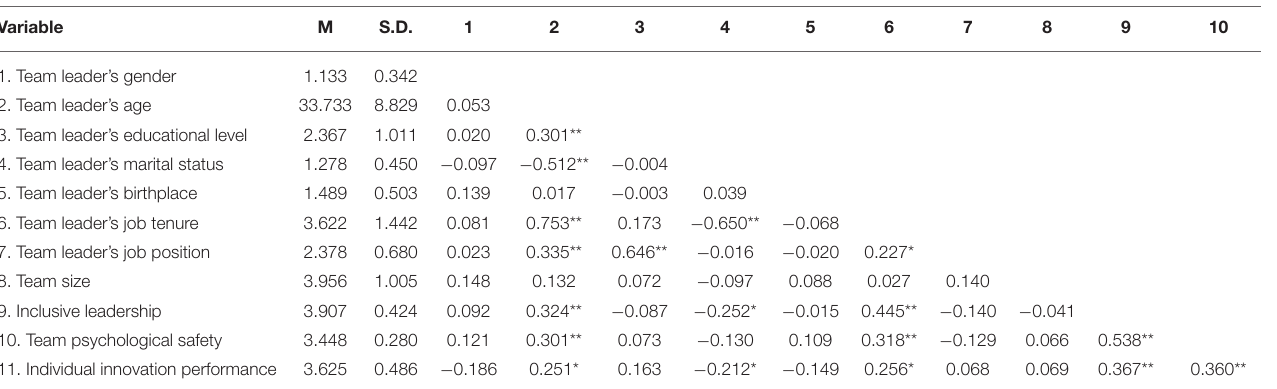
TABLE 4 | Means, standard deviations, and correlations among variables at the team level.